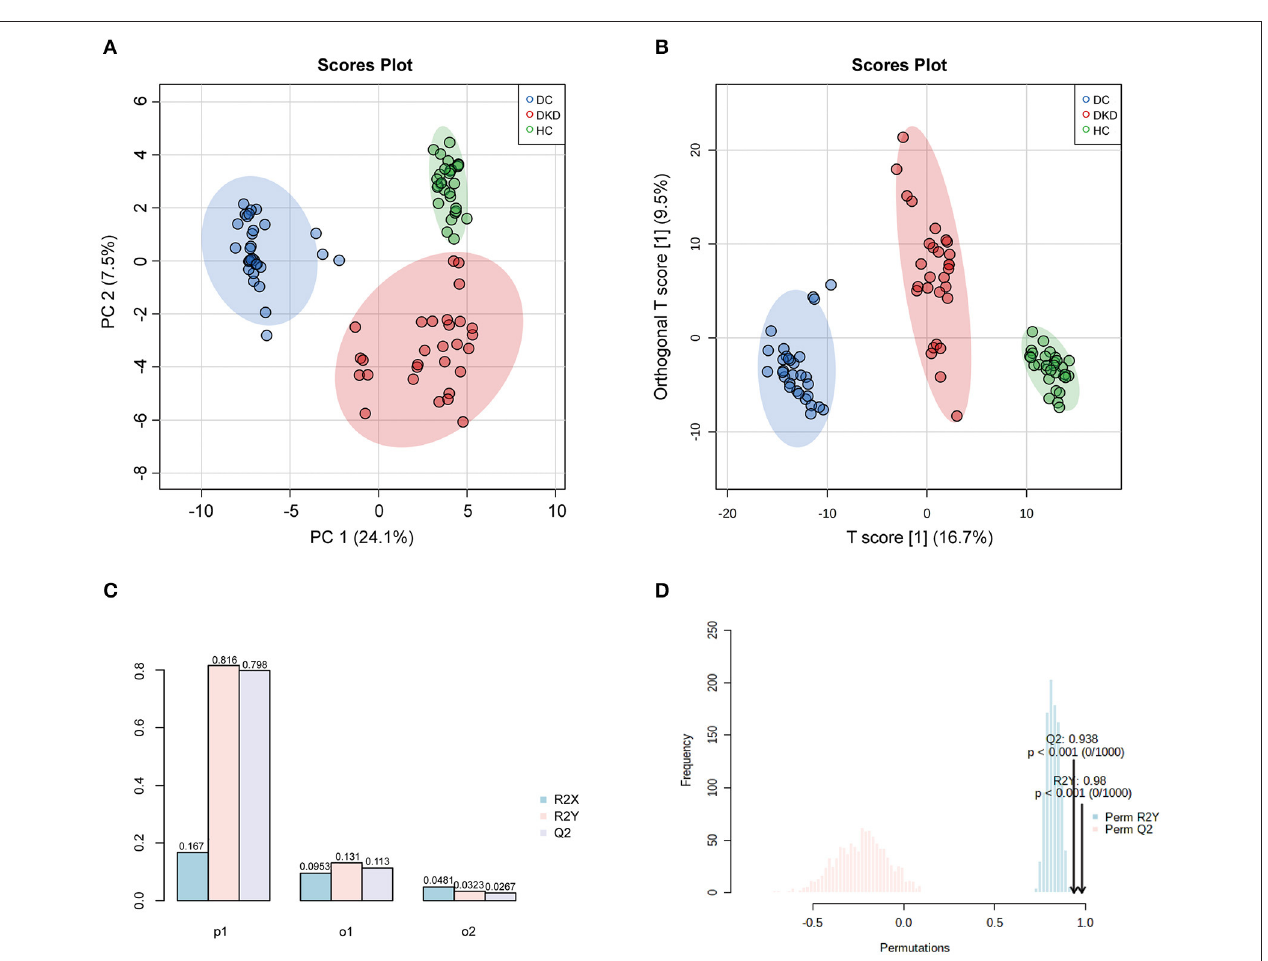
FIGURE 2 | Overall similarity and differences between samples by PCA and OPLS-DA analysis. (A) PCA score plots of healthy controls (HC), diabetic controls (DC), diabetic kidney disease patients [DKD, i.e., Diabetic nephropathy (DN)]. (B,C) OPLS-DA score and model overview plots of HC, DC, and DKD. (D) 1,000-times permutation test of the model showed its high strong